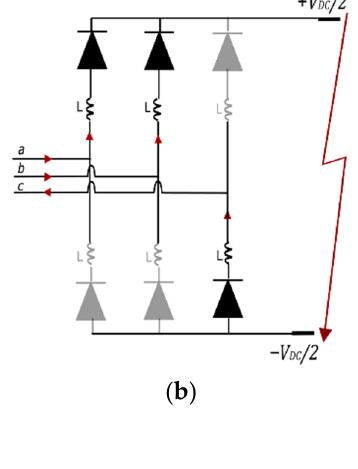
( d ) Figure 6. ( a ) Single thyristor switch scheme; ( b ) Single thyristor switch scheme equivalent circuit during fault; ( c ) Double thyristor switch scheme; ( d ) Double thyristor switch scheme equivalent circuit during fault. 3. SM Configurations In the following subsections, the pros and cons of several noteworthy MMC SM con- figurations with fault blocking capability will be discussed. 3.1. SMs Based on Standard HB and FB Structures Removing a single IGBT from the standard FBSM results in the unipolar full-bridge submodule (UFBSM) structure [51], as shown in Figure 7. Since D3 is unidirectional, the SM is unable to generate a negative voltage during normal operation. Fault blocking op- eration remains intact, but overmodulation is no longer possible. This structure features a slightly lower device count than the FBSM, albeit with similar conduction losses. Blocking State 𝑖 (cid:3046)(cid:3040)